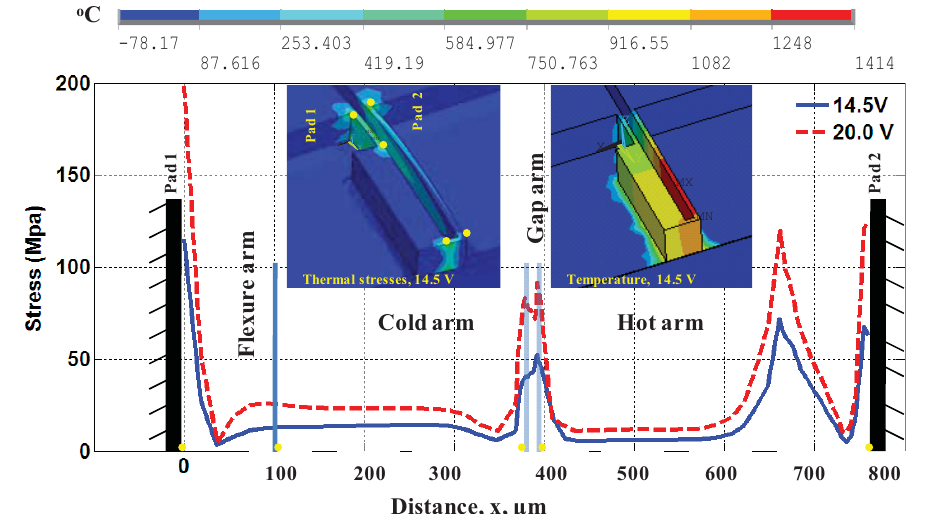
Figure 8. Thermal stress and temperature distribution of folded beam actuator.